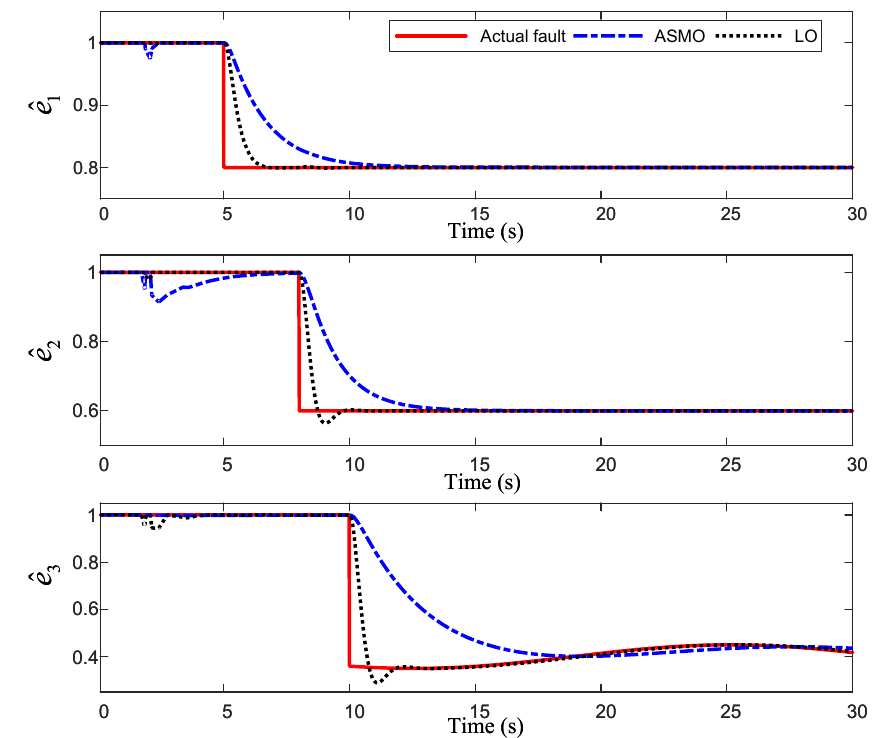
Figure 2. The estimation of